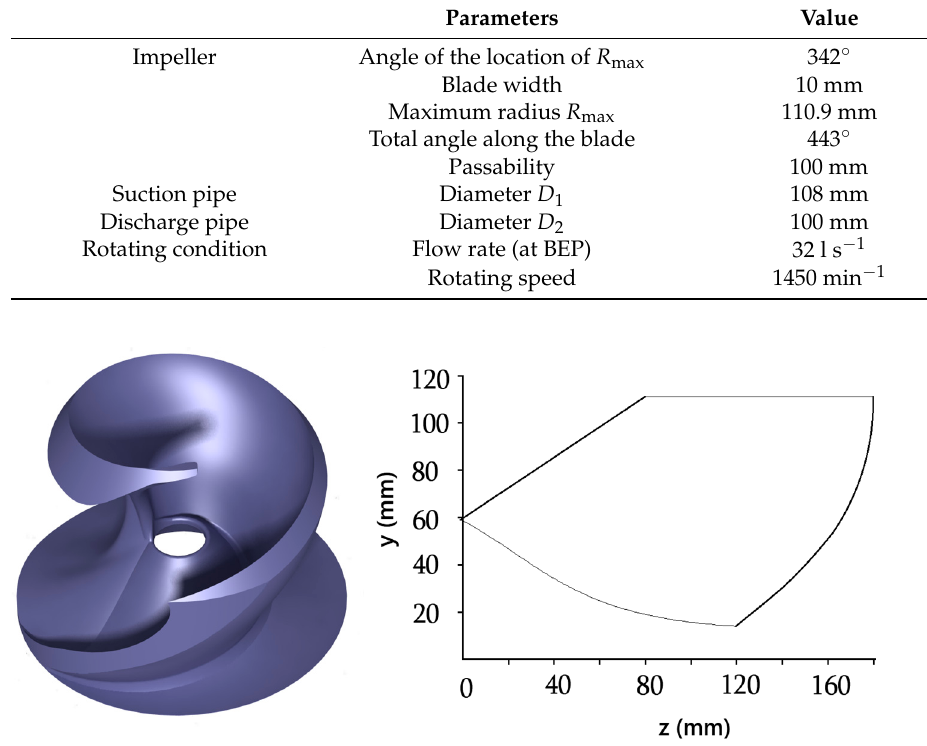
Figure 2. Investigated impeller and its meridian section . Table 1. Specifications of the single blade centrifugal pump.